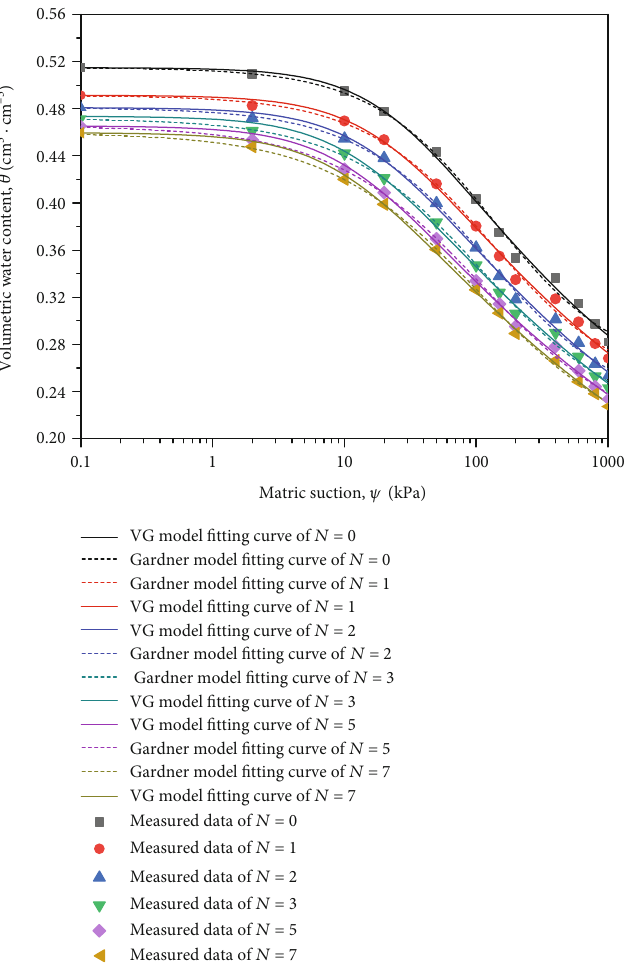
Figure 3: SWCC trend diagram of residual soil simulated by Gardner and VG model